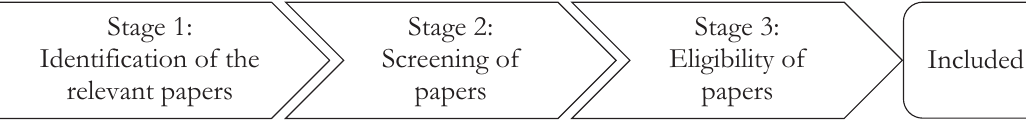
Figure 2. Stages of Systematic Literature Review (SLR)